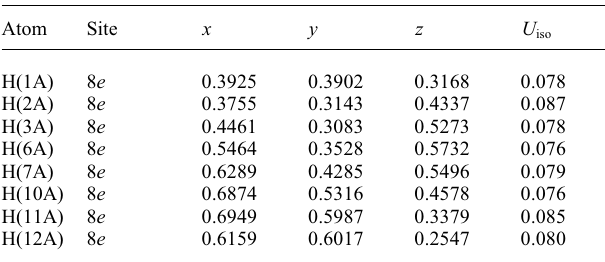
Table 2. Atomic coordinates and displacement parameters (in Å 2 )